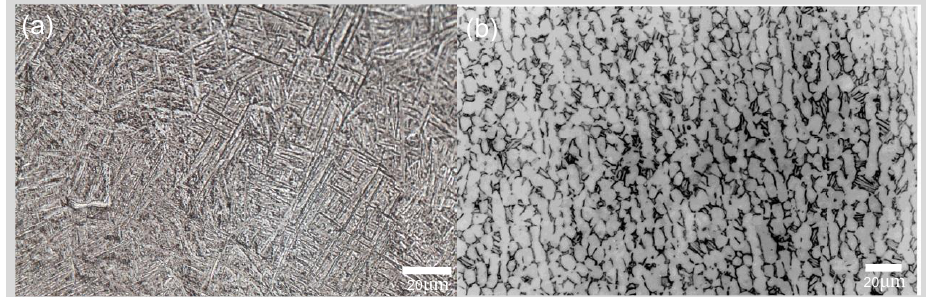
Figure 5. SEM images showing microstructures of Ti6Al4V produced by DMLS ( a ) and conventional process ( b ). Reproduced from [44,45], with permission from Elsevier, 2016 and Elsevier, 2009.